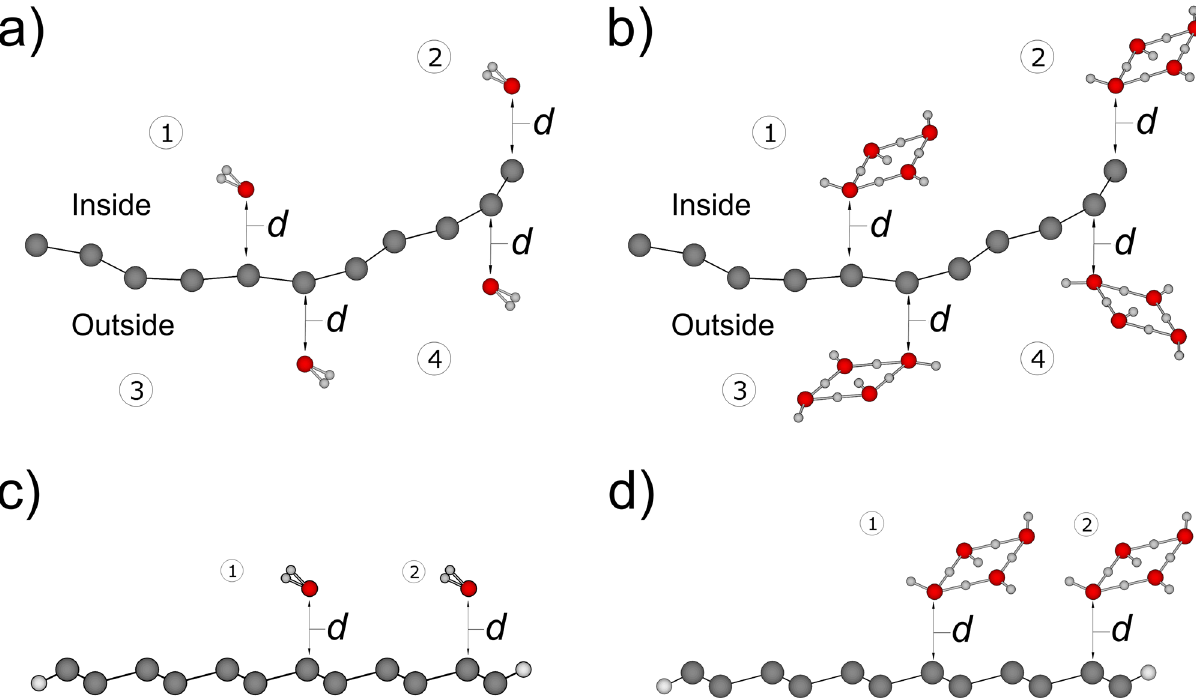
Figure 6. The stable adsorption scenarios of a water molecule and a square ice on the SND. ( a ) a water molecule adsorbed inside and outside the unsaturated SND with a curvature, at the centre and the edge: ① inside and centre, ② inside and edge, ③ outside and centre, and ④ outside and edge. ( b ) a square ice adsorption: ① inside and centre, ② inside and edge, ③ outside and centre, and ④ outside and edge. ( c ) a water molecule adsorbed at the centre and edge of the saturated SND: ① centre, ② edge. ( d ) a square ice adsorption: ① centre, ② edge. The stable bond lengths d are calculated as shown in Table 1. The calculations based on various initial spacings (1, 2, and 3 angstroms) are applied to each adsorption scenarios and result in stable and equivalent adsorption distances d for